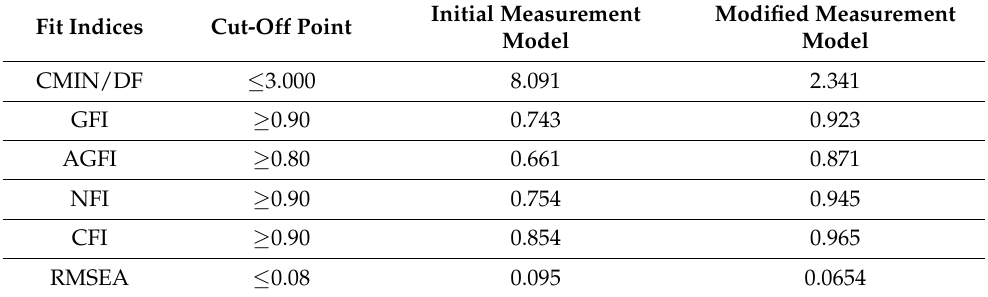
Table 3. Fit indices.